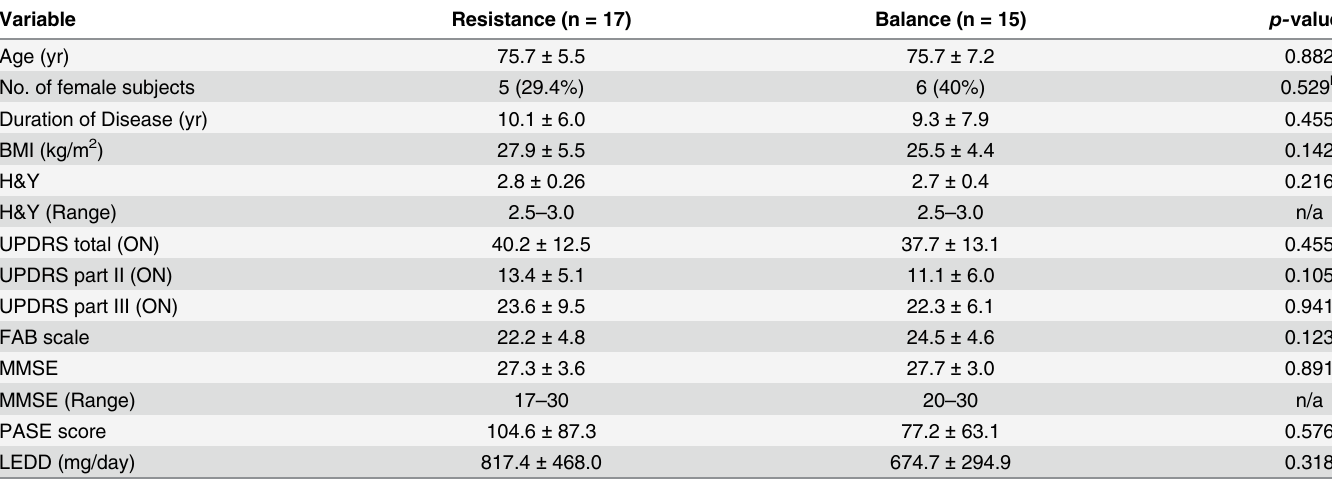
Table 1. Participant